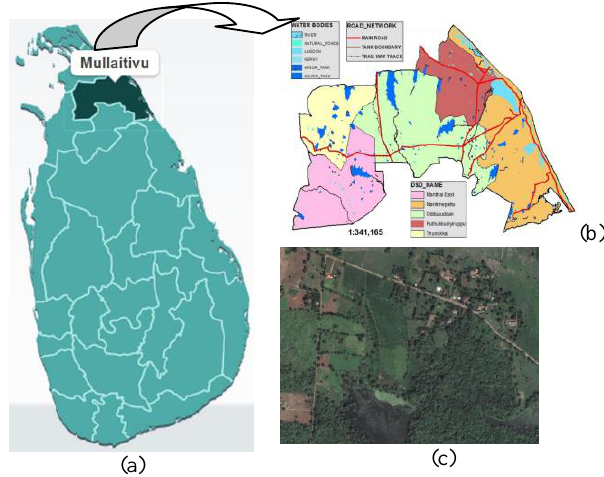
Figure 1: Study Area: (a) District Map of Sri Lanka, (b) Map of Mullaitivu portraying water features, and (c)